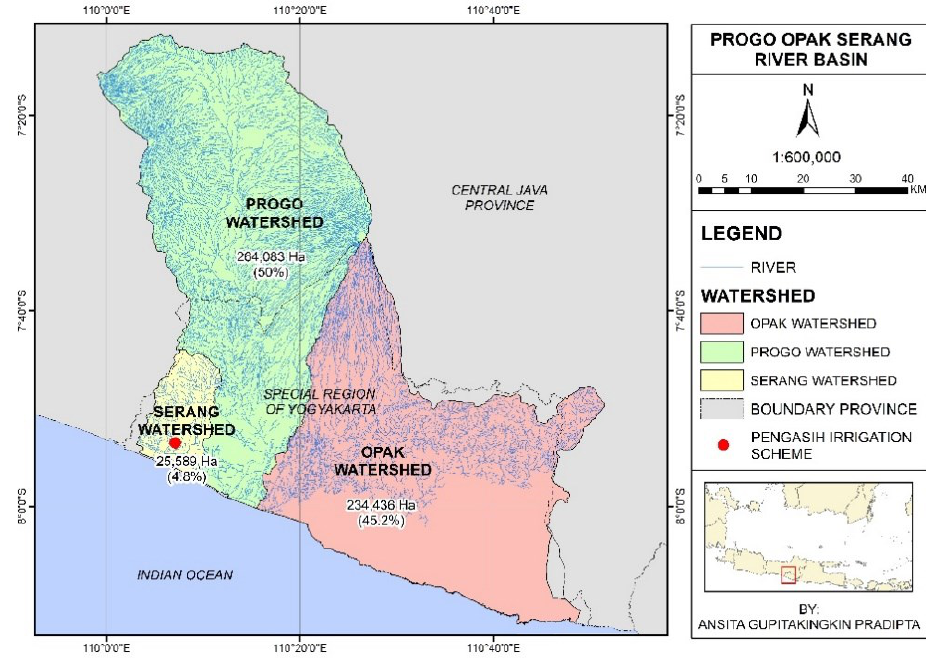
Figure 2. The research focus was on the sand trap of the Pengasih irrigation network, which is indicated by the red circle; it receives its water supply from the Serang River, which is part of the Progo Opak Serang (POS) River Basin, Indonesia. The POS River Basin is one of the cross-provincial river basins located in both the Special Region of Yogyakarta (63%) and Central Java Province (37%). Water 2022 , 14 , x FOR PEER REVIEW